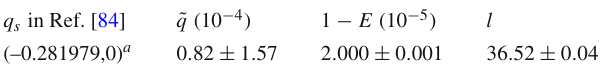
Table 1 Precessing around the hairy black hole in the view of the data for the orbit of the S2 star around Sgr A* q s in Ref.